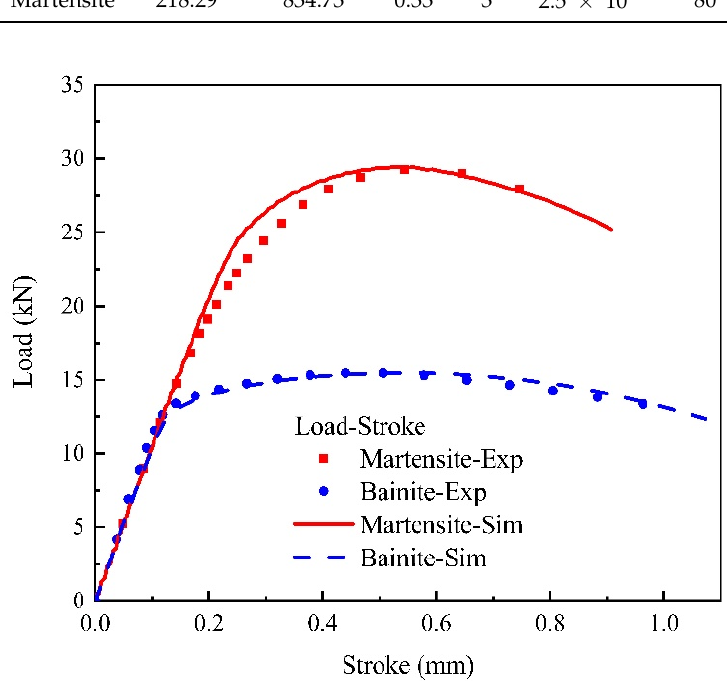
Figure 6. Load–stroke curves comparison for martensite and bainite specimens, respectively (exper- iment vs. simulation).